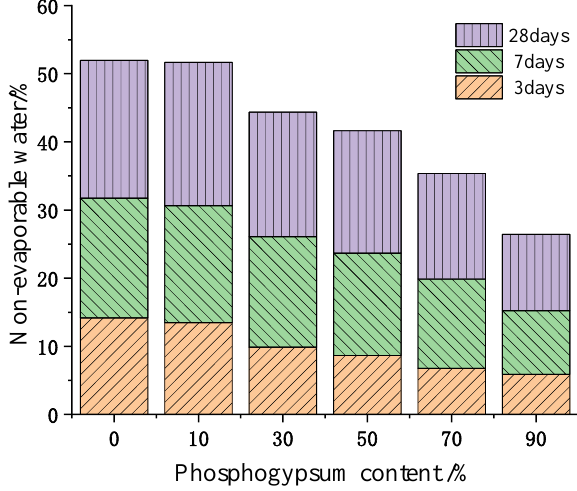
Figure 2. Non-evaporable water content of composite cementitious material.